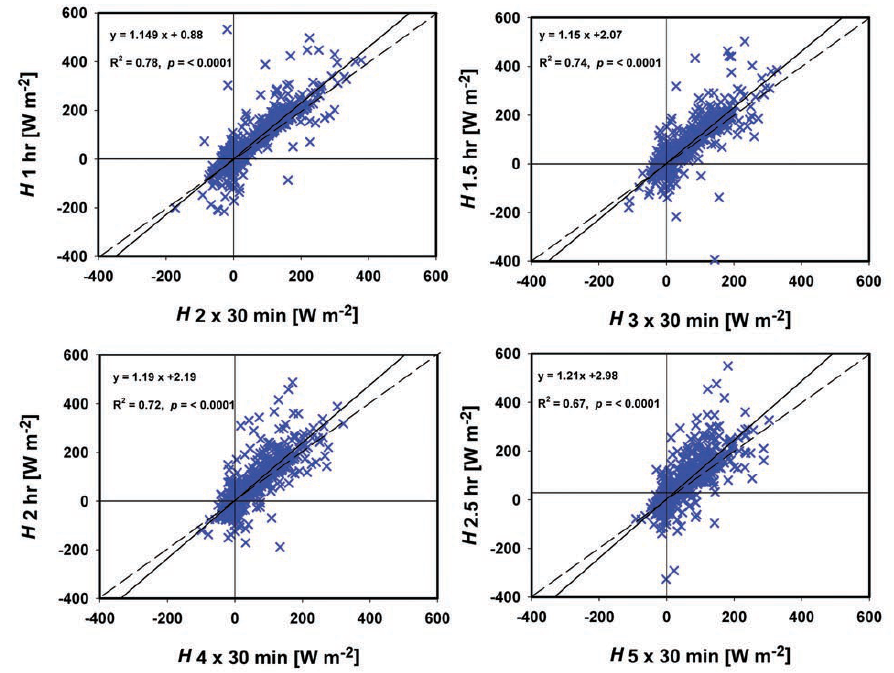
Fig. 1. An analysis of low frequency flux losses for sensible heat flux data (H ) collected at the GAW site during the OP3 campaign. Solid line shows the best linear fit and dashed line represents the 1:1 line.